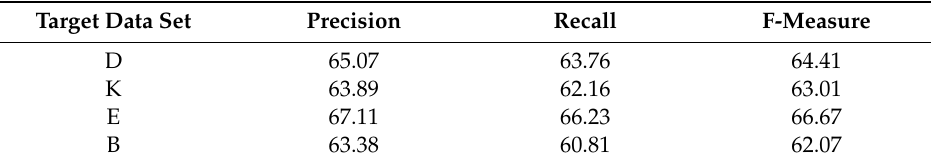
Table 3. Performance of Baseline Semi-Supervised Learning Model.